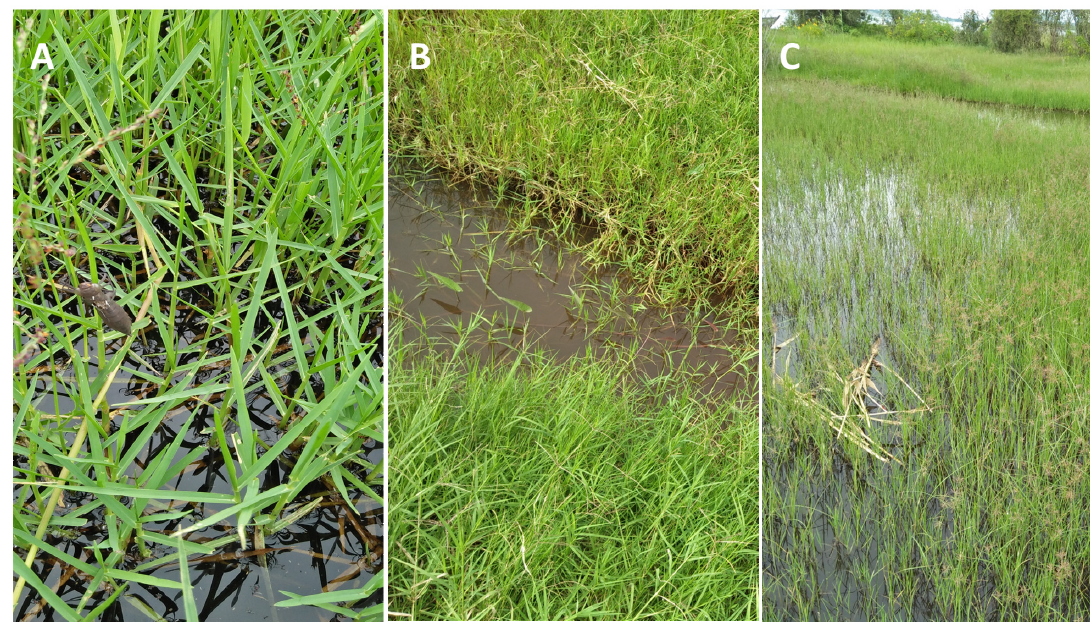
Figure 4. The most dominant graminoid plants identified during the survey. ( A ) Panicum repens (Poaceae), ( B ) Cynodon dactylon (Poaceae) and ( C ) Cyperus rotundus (Cyperaceae).